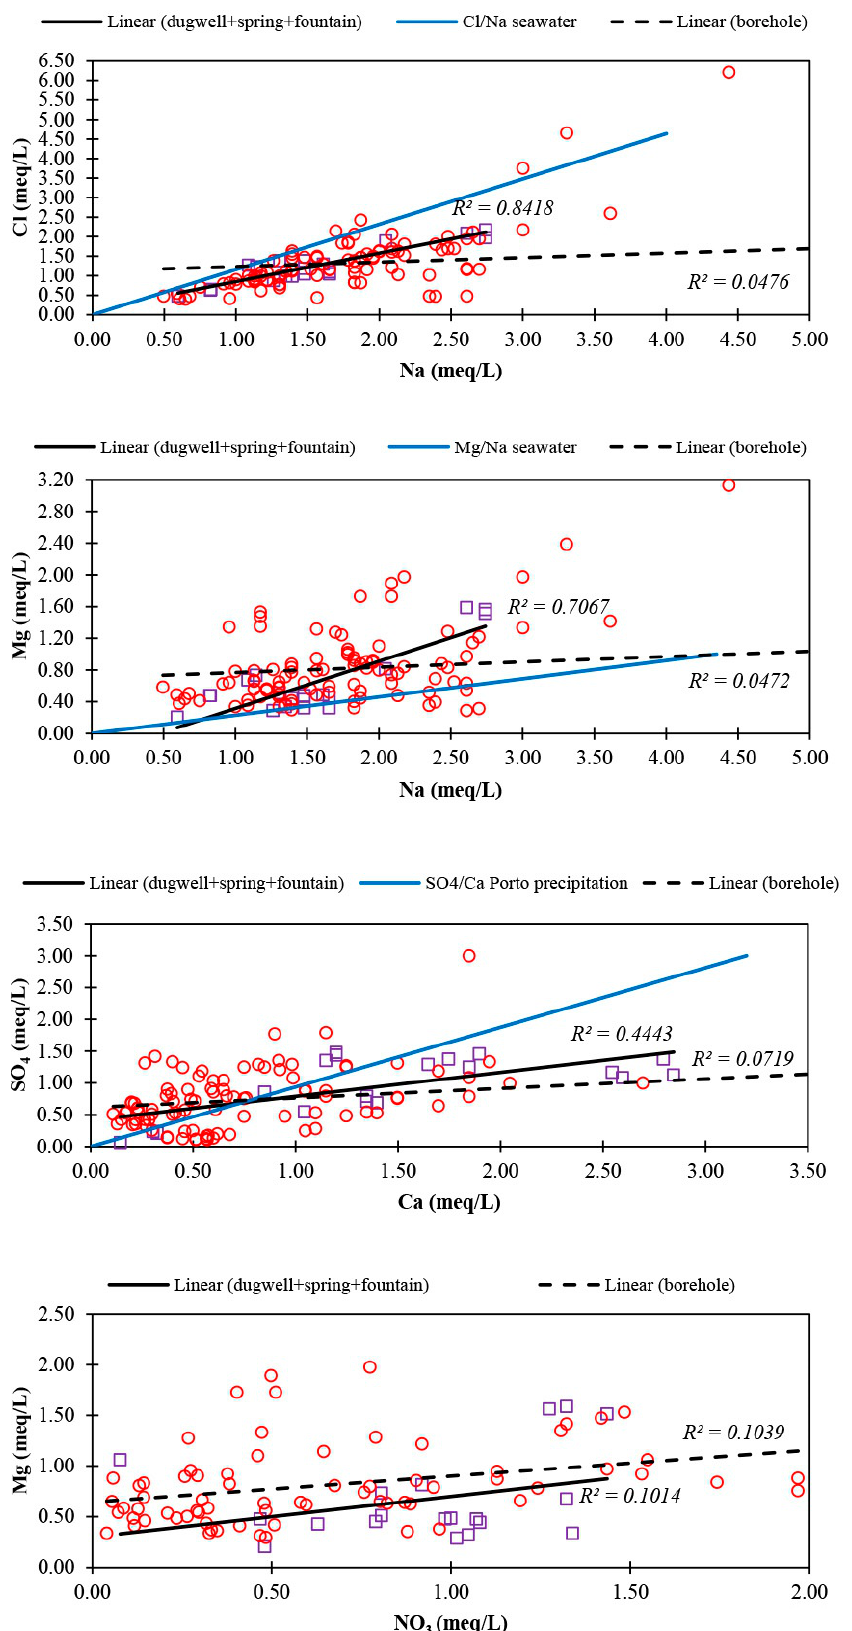
Figure 3. cont . Figure 3. Cont